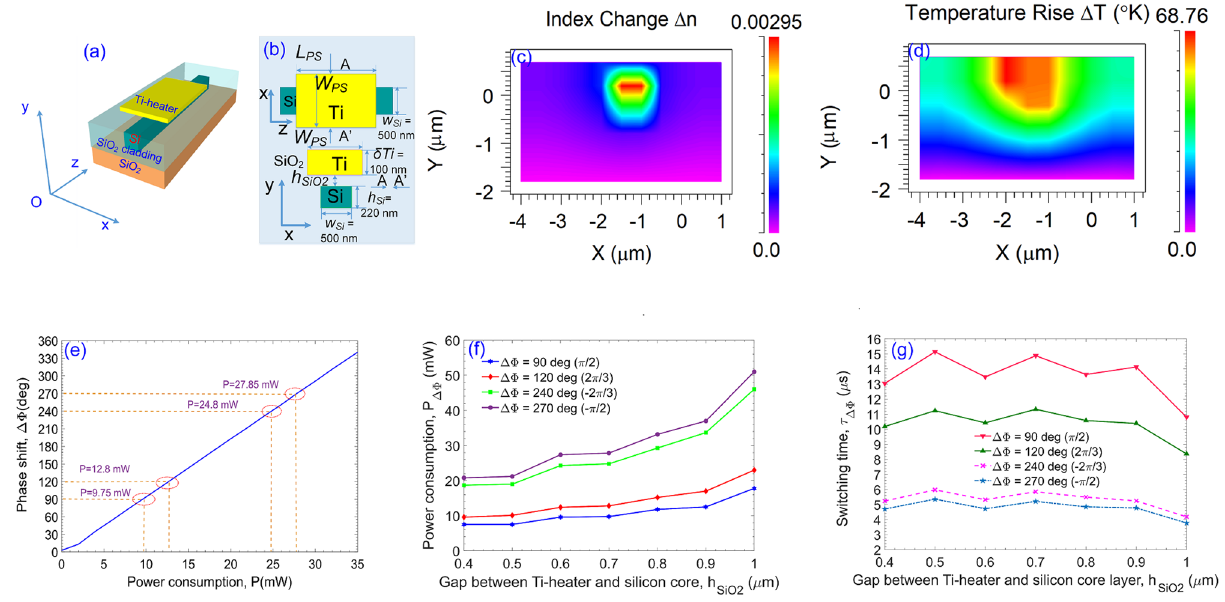
Figure 3. Operation of the TOPS using the metallic Ti-heater (a) schematic diagram of the TOPS in the 3D space, (b) side-view and cross-view of the TOPS, (c) distribution of the index change (cid:31) n of the silicon core layer via the FEM simulation method, (c) distribution of the temperature rise (cid:31) T simulated by the FEM-based multiphysics tool, (e) phase shift �φ according to electric power consumption supplied to the metallic Ti-heater, function of the silica gap h SiO 2